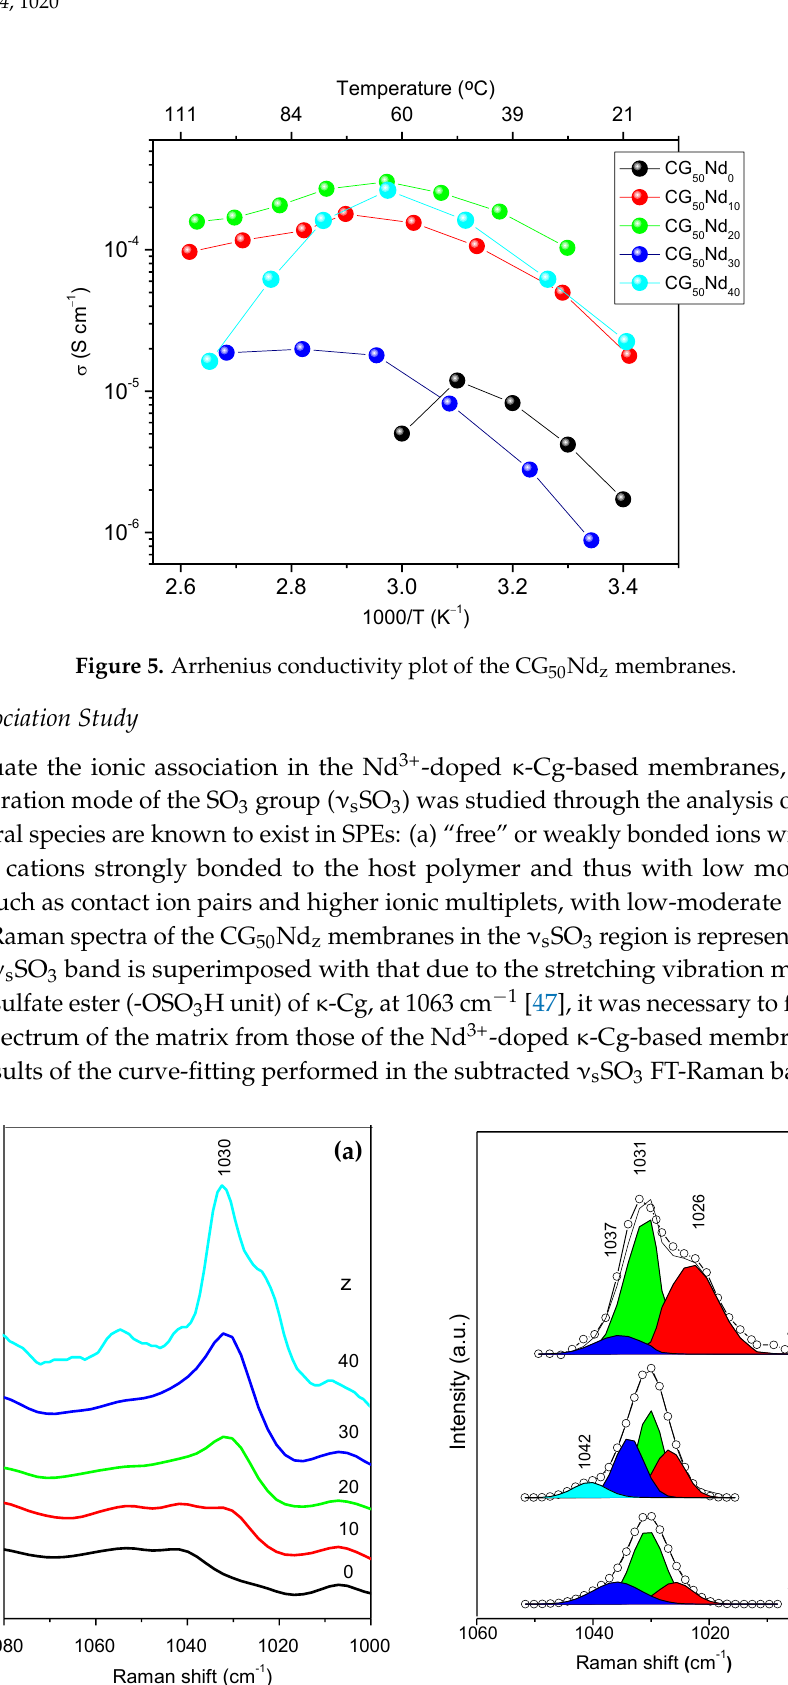
spectra ( b ) of the CG 50 Nd z membranes in the ν s SO 3 region.